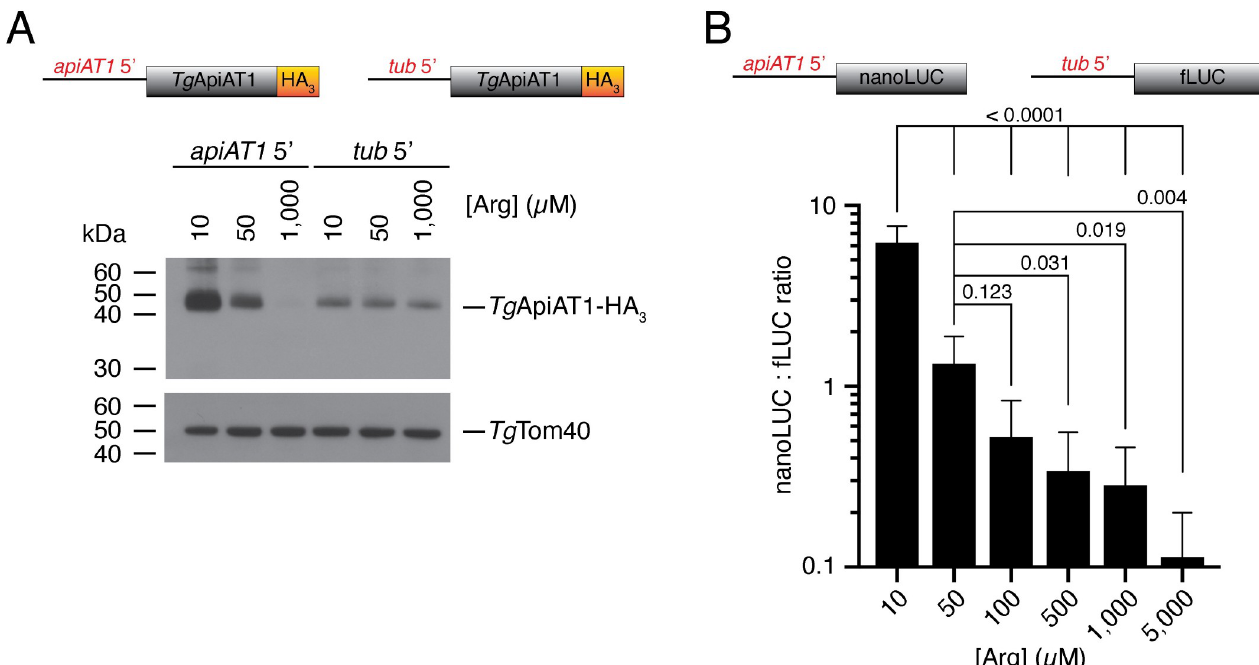
Fig 2. Arg-dependent Tg ApiAT1 regulation is mediated by the 5’ upstream region of the Tg ApiAT1 gene. ( A ) Western blot of Tg ApiAT1-HA 3 expressed from the native Tg ApiAT1 5’ region ( apiAT1 5’) or the α -tubulin 5’ region ( tub 5’), in parasites grown at a range of [Arg] in the growth medium. Tg Tom40 is a loading control. Data are representative of three independent experiments. ( B ) nanoLUC:fLUC ratio in a parasite strain expressing nanoLUC from the Tg ApiAT1 5’ region ( apiAT1 5’-nanoLUC) and fLUC from the α -tubulin 5’ region ( tub 5’-fLUC), and grown at a range of [Arg] for 40–42 hr. Data represent the mean ± SD from nine independent experiments. P values were calculated using a one-way ANOVA with Tukey’s multiple comparisons test. P values not shown were >